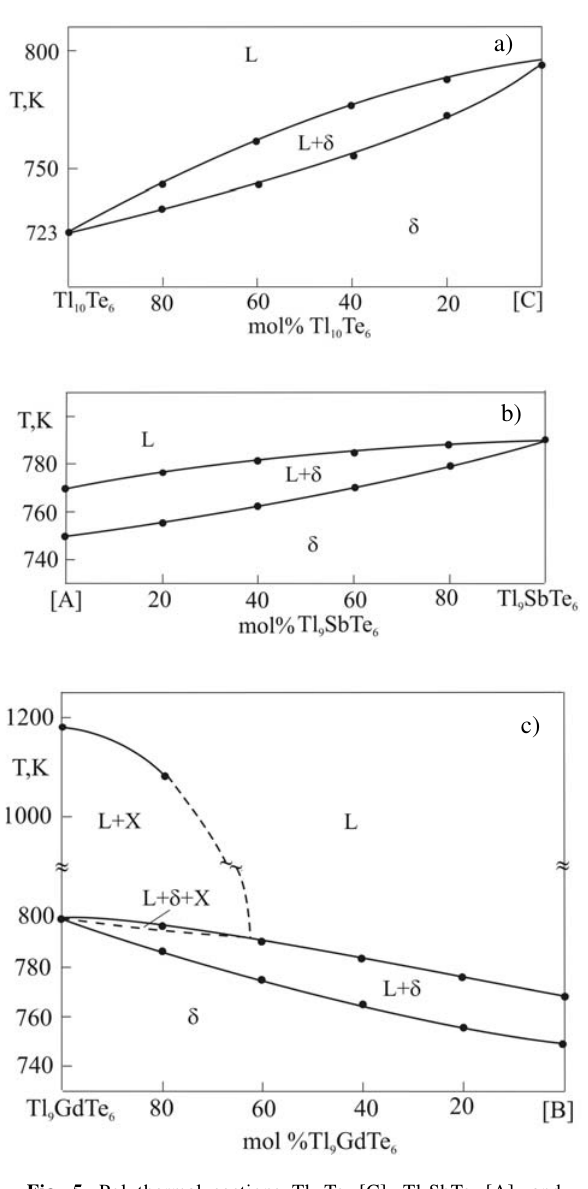
Fig. 5. Polythermal sections Tl Tl